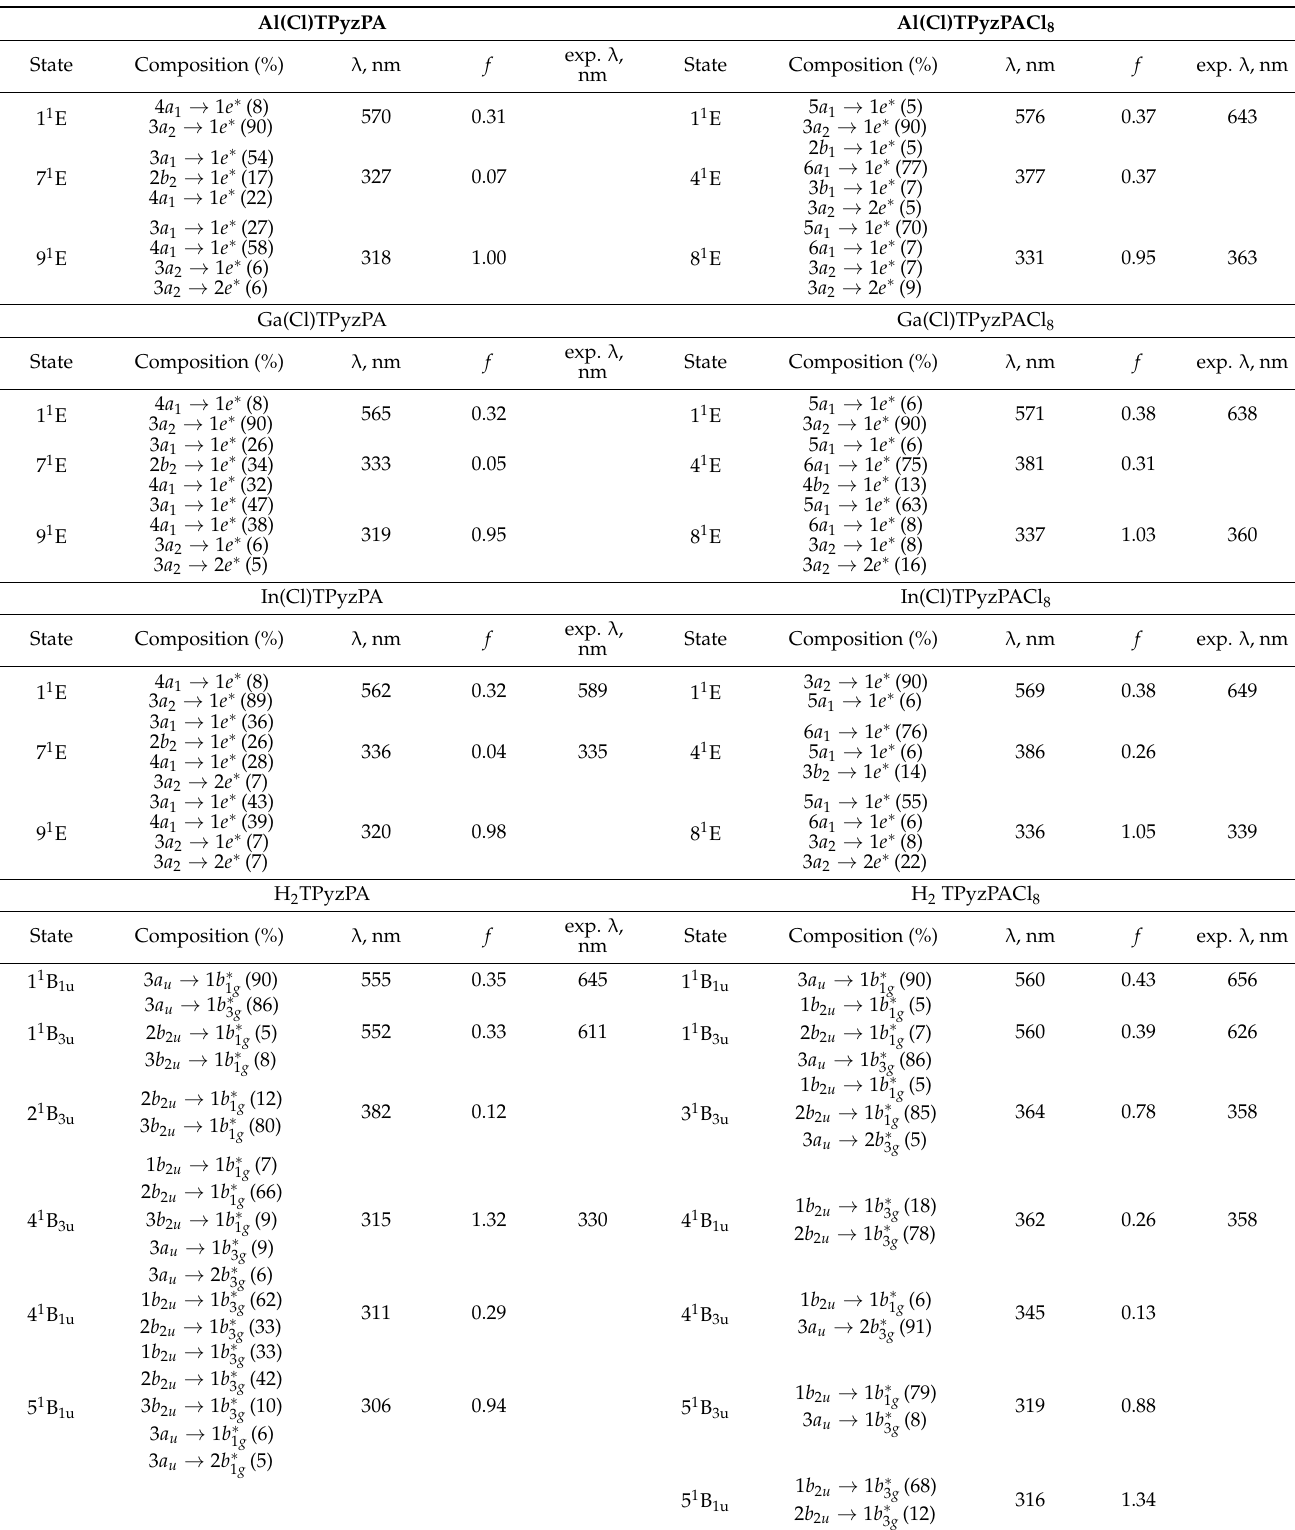
Table 3. Calculated composition of the lowest excited states and corresponding oscillator strengths for TPyzPA and TPyzPzCl 8